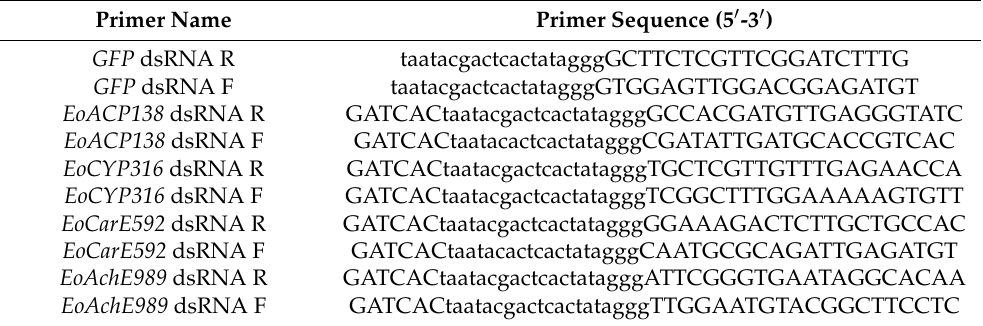
Table 2. Sequences of the primers for